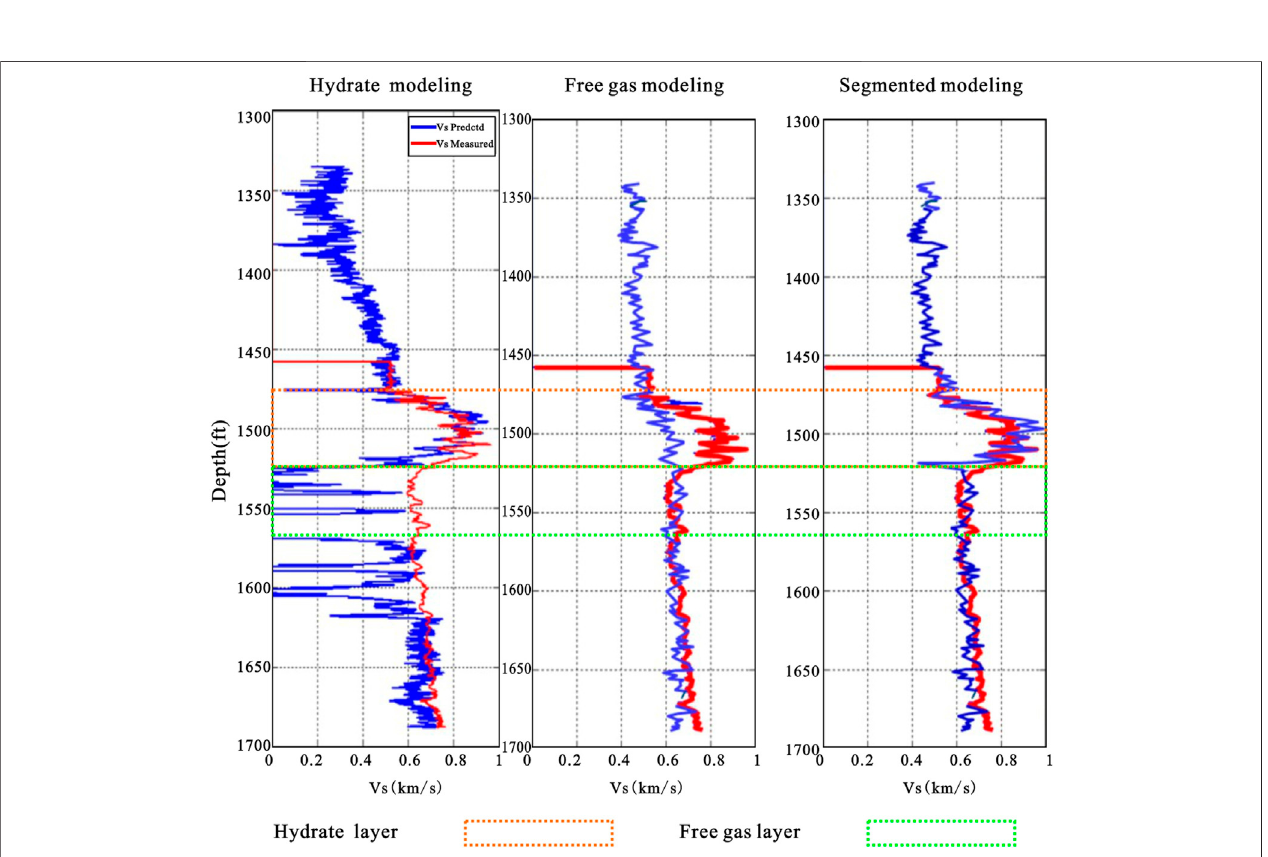
FIGURE 14 | S-wave velocity prediction results based on segmented modeling idea.